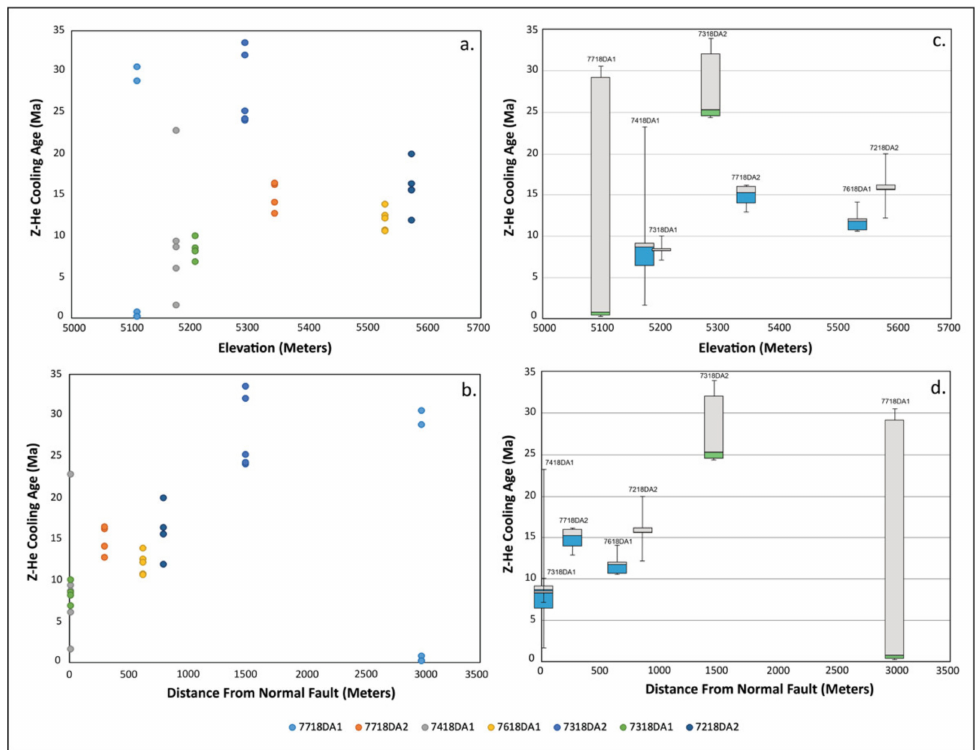
Figure 7. ZHe thermochronology cooling ages plotted ( a ) vs. elevation and ( b ) vs. distance measured orthogonal from the trace of the horst-bounding normal fault. Panels ( c , d ) are box and whisker plots visually depicting the same data presented in panels ( a , b ). Samples depicted with blue and gray box and whisker plots were collected from the central horst of the Dajiamang Tso rift, while the green and gray box and whisker plots represent the two samples collected from the hanging walls of the Dajiamang Tso rift and Great Counter thrust. The line dividing the two colors within each box and whisker plot represents the median, the lower and upper box boundaries represent the 1st and 3rd quartiles, respectively, and the error bars represent the minimum and maximum values of the analyzed grains. Note the roughly positive correlations within the footwall samples (blue/gray) between ZHe cooling age and (1) elevation and (2) distance from the normal